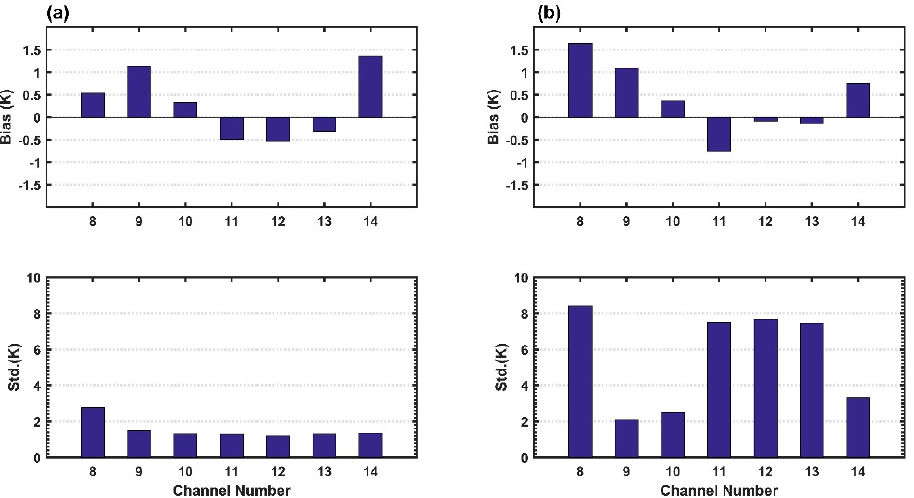
Figure 7. Biases (top panel) and standard deviations (bottom panel) statistics for all data over the ocean ( a ) and land ( b ) with satellite zenith angles less than 60°.